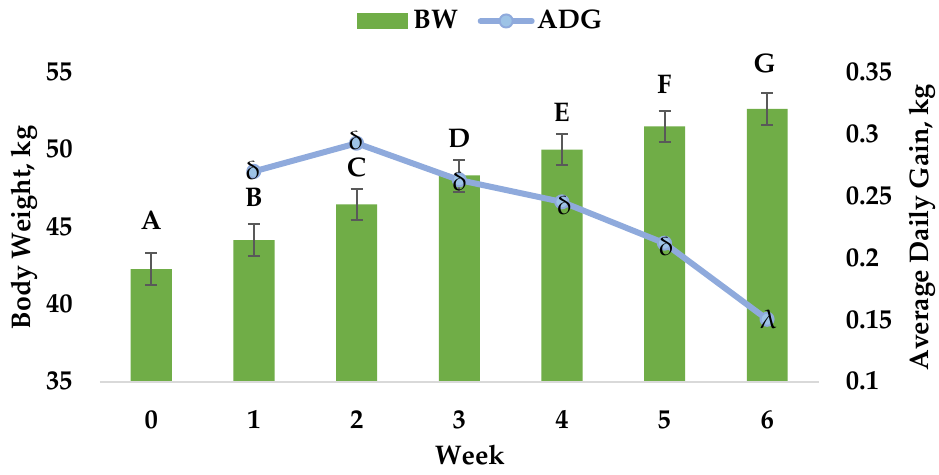
Figure 4. Average lamb body weight (BW), left axis, and average daily gain (ADG), right axis, across the trial of lambs artificially infected with H. contortus . Lambs were weighed at weekly intervals and ADG was calculated by subtracting the lamb’s BW at the previous week from the BW of the current week, then dividing by the number of days in between those two measurements.